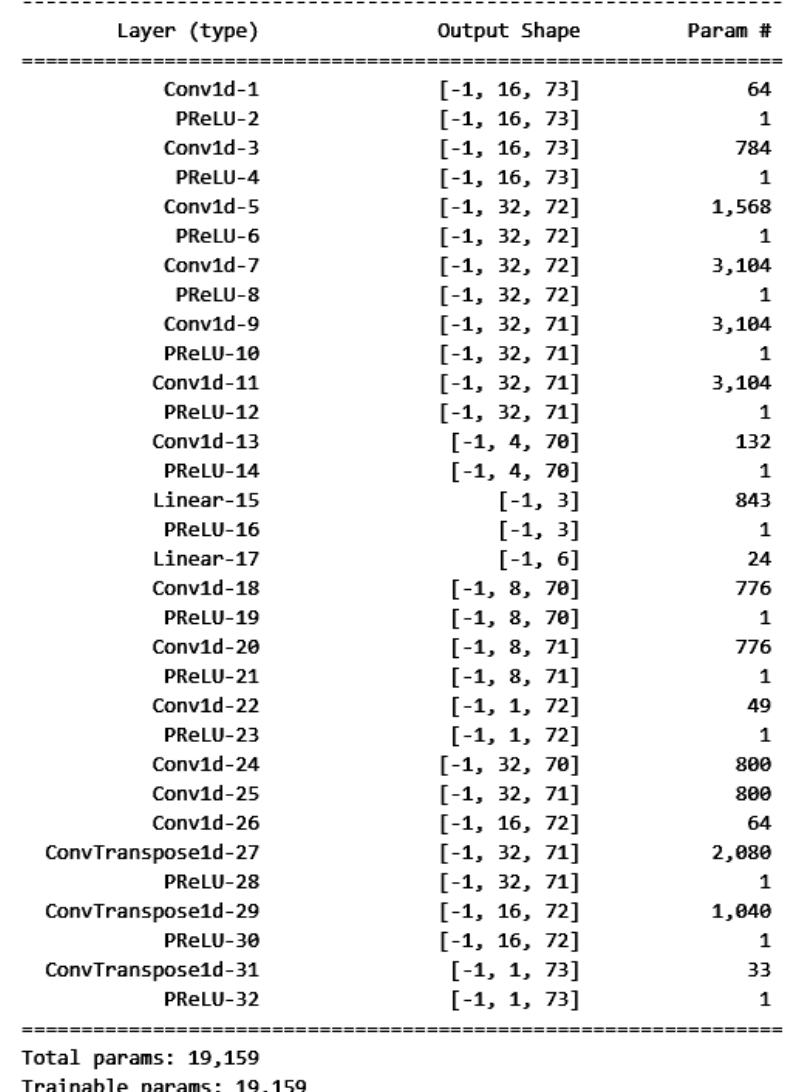
Figure 7. Deep network architecture. Table 4. Training parameters .